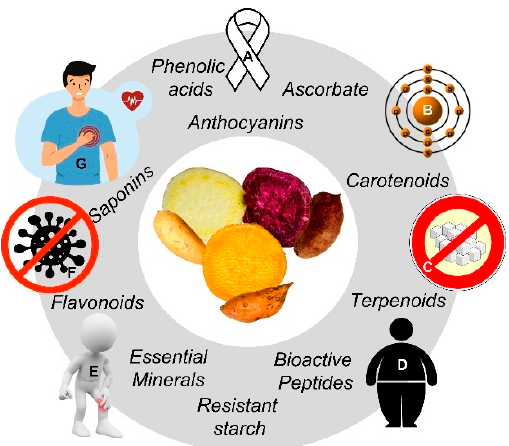
Figure 1. Sweet potato (SP; Ipomoea batatas L.) group of phytochemicals with associated health-promoting effects. Preventive actions (clockwise): Immunocompromise ( A ), prooxidant ( B ), diabetes ( C ), adiposity ( D ), inflammatory ( E ), infection ( F ), cardiovascular ( G ) diseases/metabolic rearrange- ments. Source: The authors (CC (by/nc/sa)-licensed clip art).